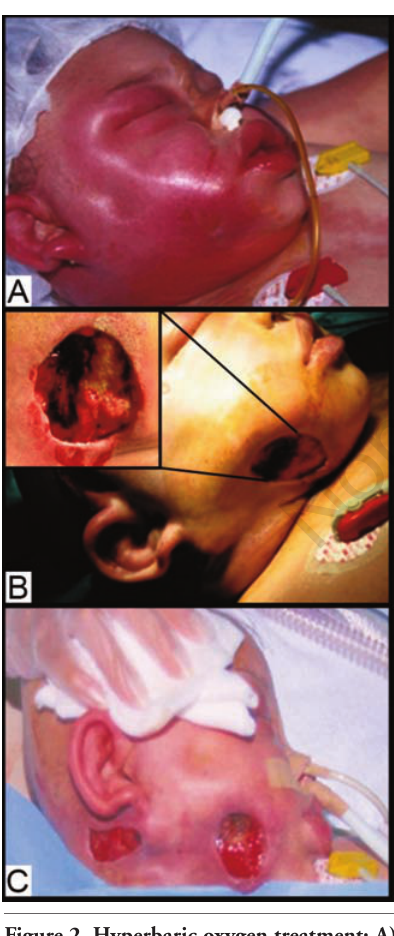
Figure 2. Hyperbaric oxygen treatment: A) a child with gas gangrene of the head/neck region; B) a child into the hyperbaric room (intubated and ventilated); C) respi- ratory